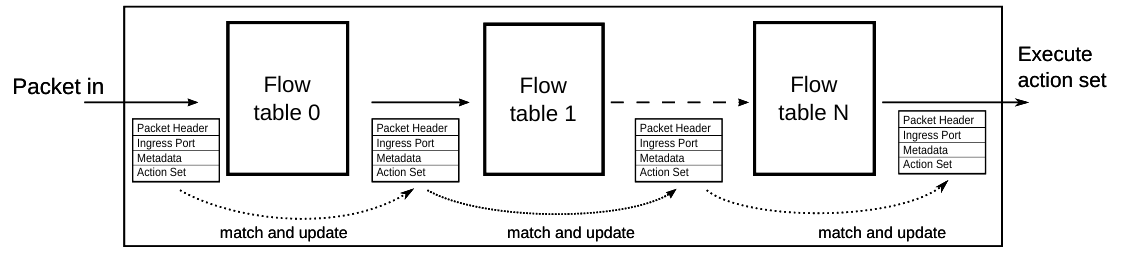
Figure 5. OpenFlow pipeline.